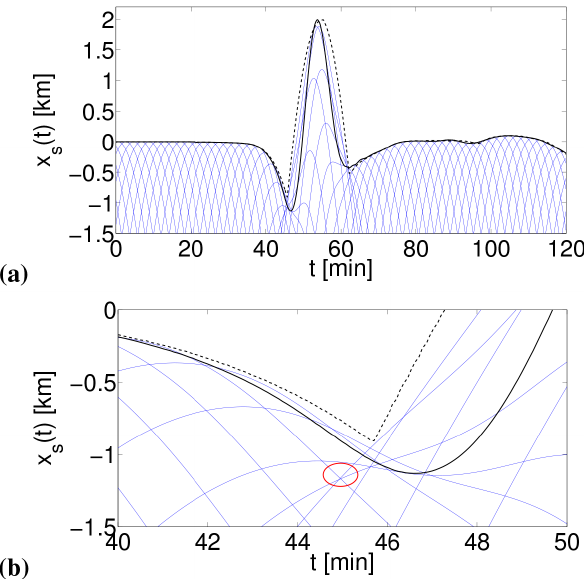
Figure 18. Shoreline movement (a) and an inset (b) of a break- ing wave simulation. The linear model coupled to NSWE is shown by the dashed line, while the solid one is the shoreline movement of a linear model simulation with EBC implementation. Paths of the first-order characteristic curves are shown by thin lines. Break- ing occurs when two incoming characteristic curves intersect before reaching the shoreline. It is indicated by the red oval at approxi- mately t =